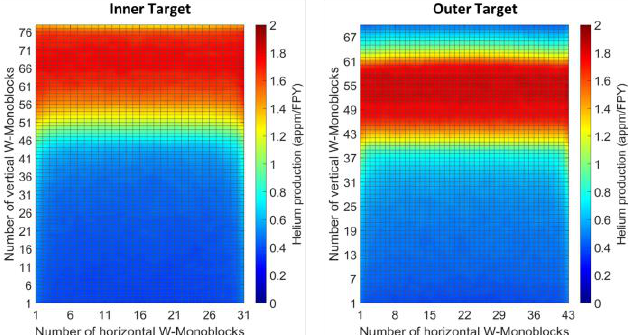
Figure 24. He-production (appm/FPY) distribution on W-monoblocks of the inner ( left ) and outer ( right ) target, with HCPB blanket.